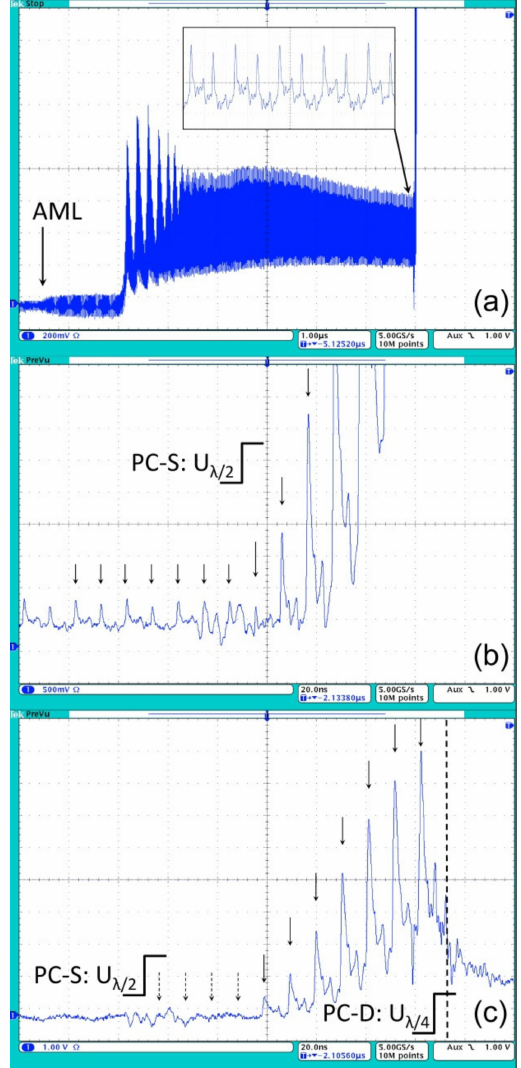
Figure 6. Signal of fast PD detector registered with the oscilloscope: ( a ) Long train of picosecond pulses; ( b ) Initial part of the short train; ( c ) Short train of picosecond pulses. PC-S U λ /2 indicates the front of the half-wave voltage applied to the modulator PC-S; PC-D U λ /4 indicates the front of the quarter-wave voltage applied to the modulator